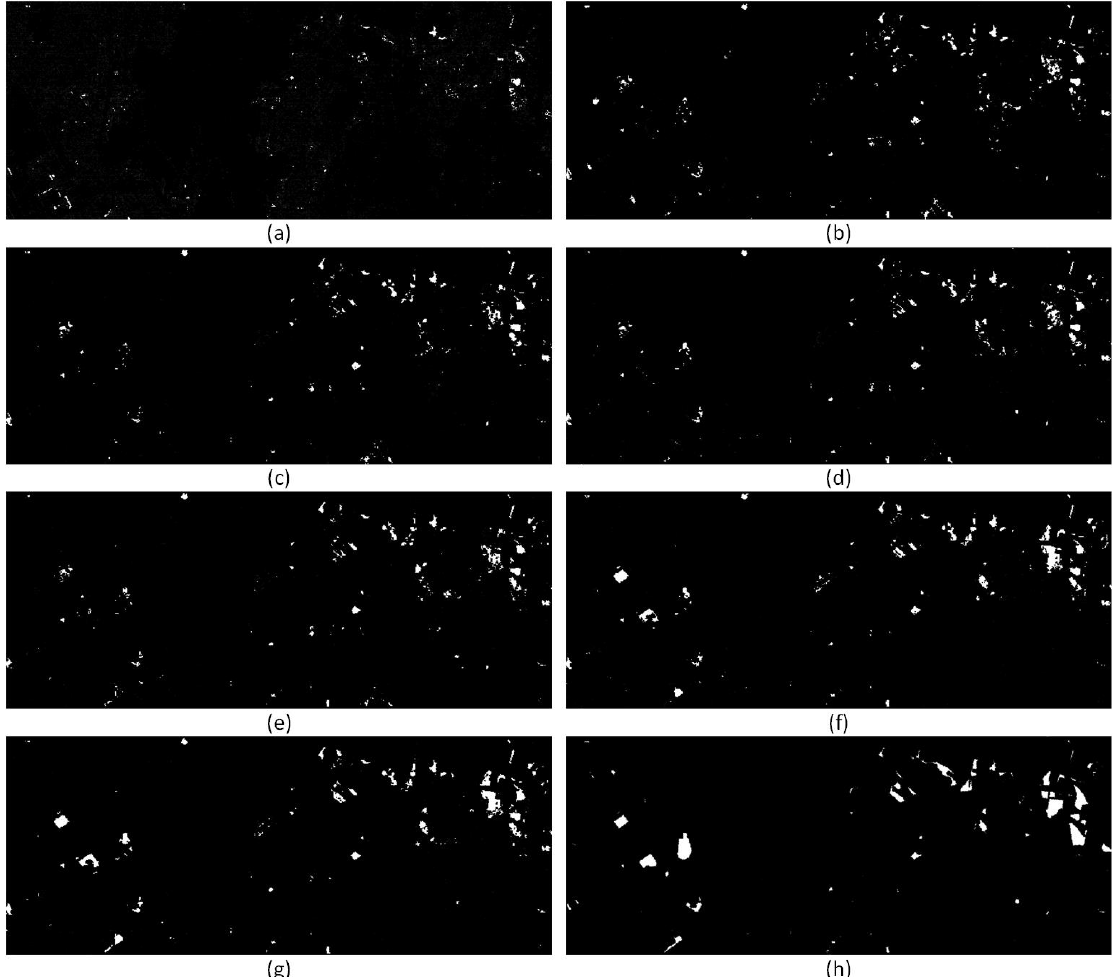
Figure 8. The change detection results of comparative methods on the test area of Shenzhen dataset: Table 3. Overall accuracy, Kappa coe ffi cients and F1 score over state-of-the-art methods on SZTAKI and Shenzhen datasets, and the size and processing rate of their models. The best values are in bold.